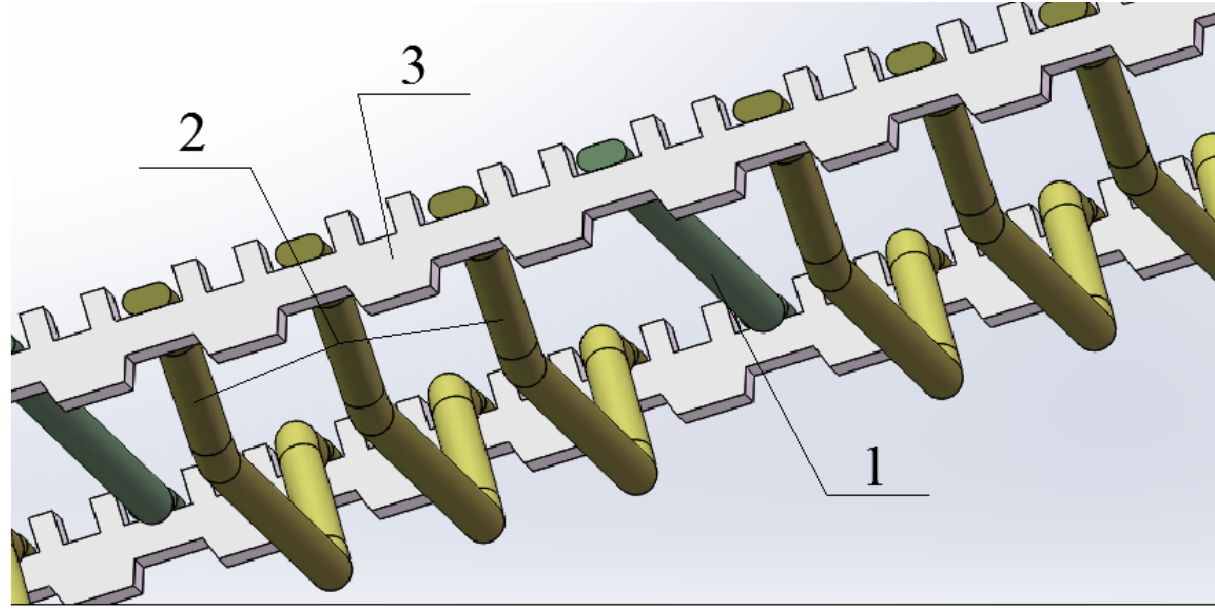
Figure 6. Structure diagram of groove-type rod under ‘one straight and three bent’ model. Note: 1. straight rod; 2. bending rod; 3. tooth rubber belt.